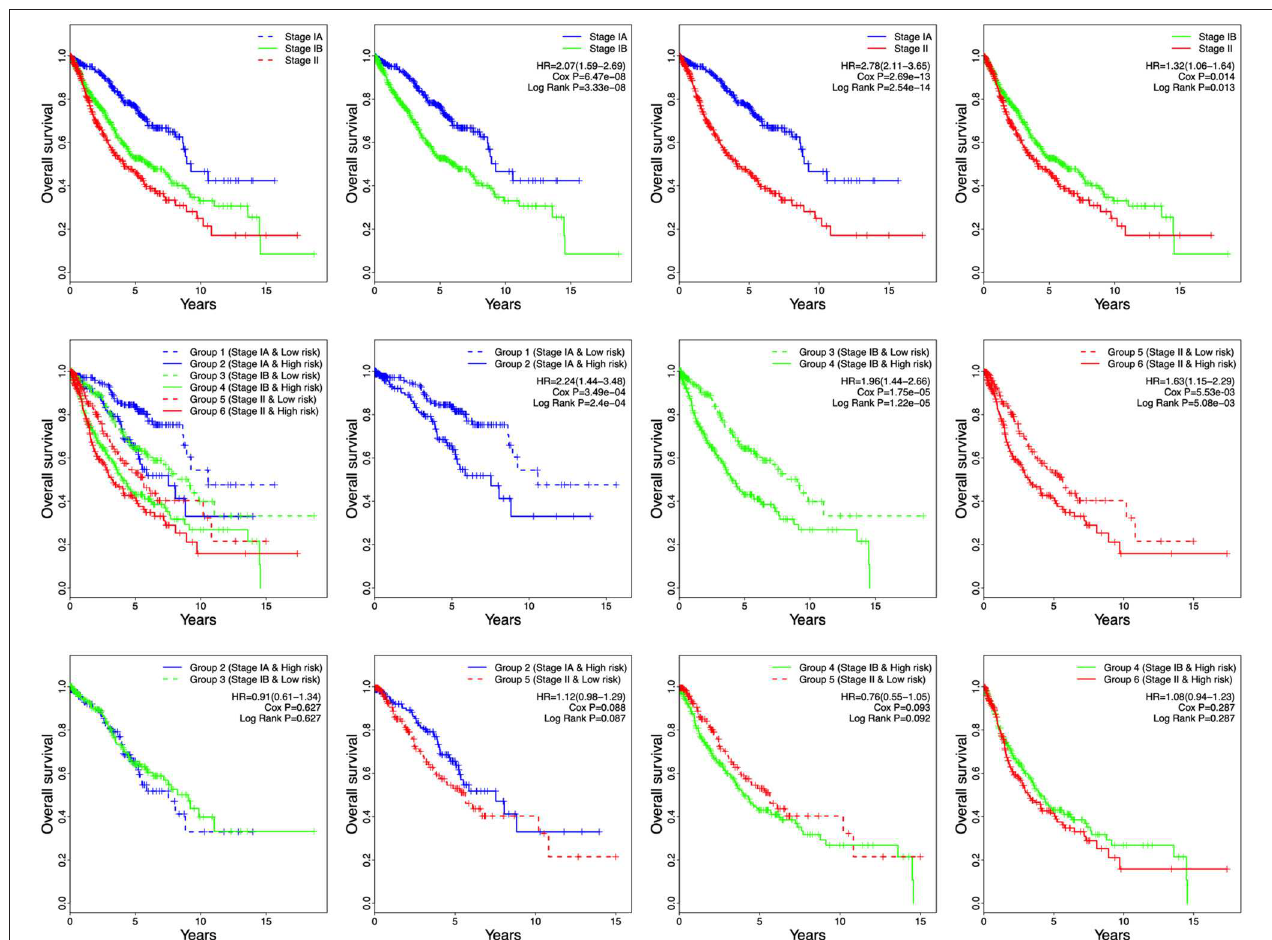
FIGURE 6 | Kaplan-Meier analysis of overall survival for patients grouped by stage and 8-gene signature